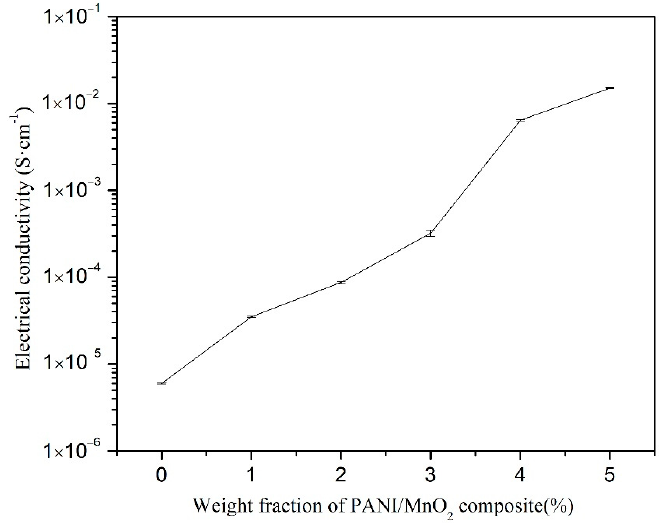
Figure 10. Electrical conductivity of the cement-matrix composites containing different dosages of PANI/MnO 2 composite.